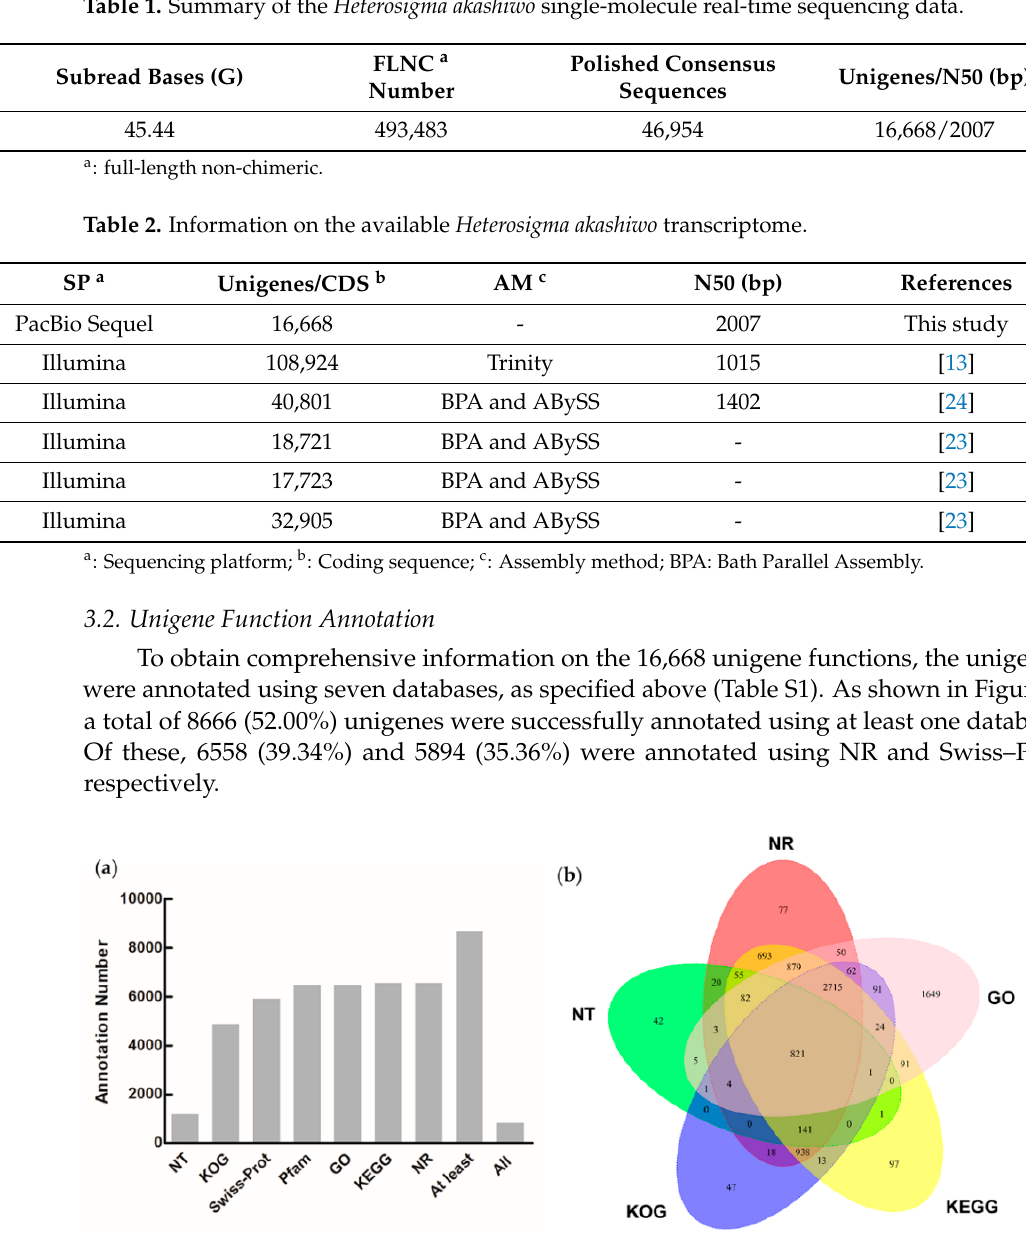
Figure 1. Functional annotation of the Heterosigma akashiwo full-length transcriptome. ( a ) Summary of the unigene annotation with seven public databases. At least: the number of unigenes that were annotated with at least one database. All: the number of unigenes that were annotated with all the databases; ( b ) Venn diagram of the annotation among the five databases.